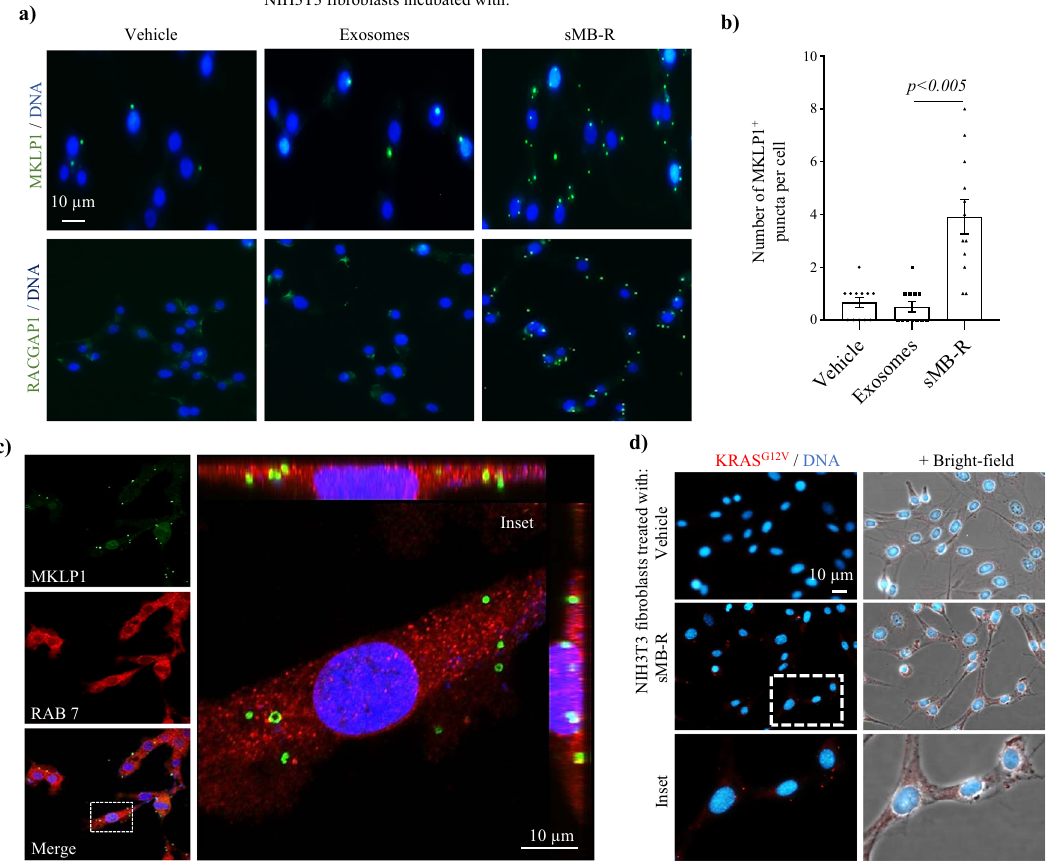
Fig. 4 Internalisation of cancer cell-derived shed midbody remnants by fi broblasts. a Uptake of sMB-Rs by fi broblasts. Fluorescence microscopy analysis of NIH3T3 fi broblasts incubated with/without SW620 cell-derived sMB-Rs or Exos (50 µ g ml − 1 ) for 2 h using anti-MKLP1 and anit-RACGAP1 antibodies. b Uptake and accumulation of sMB-Rs in NIH3T3 fi broblasts was quanti fi ed by counting MKLP1 + puncta per cell; data represented as mean ± s.e.m. Nuclei (blue) were stained with Hoechst. Scale bar, 10 µ m. c Internalisation of sMB-Rs by fi broblasts. Confocal microscopy of NIH3T3 fi broblasts incubated with sMB-Rs using anti-MKLP1 (in green) and anti-RAB7 (in red) antibodies. Confocal microscopy analysis along Z-axis (inset) reveal internalisation of sMB-Rs following uptake. Scale bar, 10 µ m. d Intercellular transfer of sMB-R KRAS G12V into NIH3T3 cells. Fluorescence microscopy of NIH3T3 fi broblasts incubated with SW620 cell-derived sMB-Rs (5 µ g) for 2 h using anti-KRAS G12V antibodies. Nuclei were stained with Hoechst stain (blue). Right panel represents fl uorescence signals from left panel overlaid onto bright- fi eld images. Inset represents enlarged image. Scale bar, 10 µ